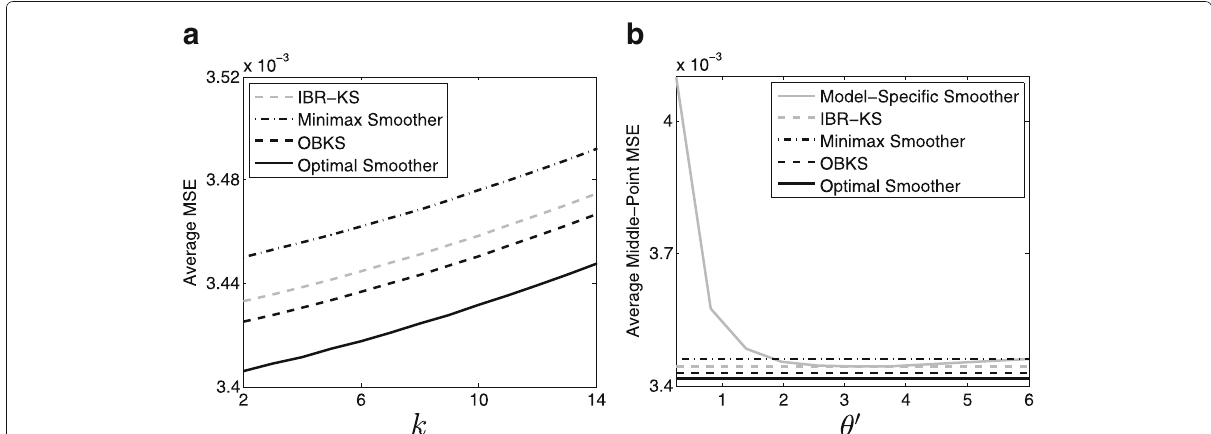
Fig. 11 Performance comparison of different Kalman smoothers for network inference. a Average MSE across the observation window. b Average middle-point MSE show the average of the optimal MSEs obtained by the optimal smoothers. This figure verifies the promising per- formance of the OBKS approach.